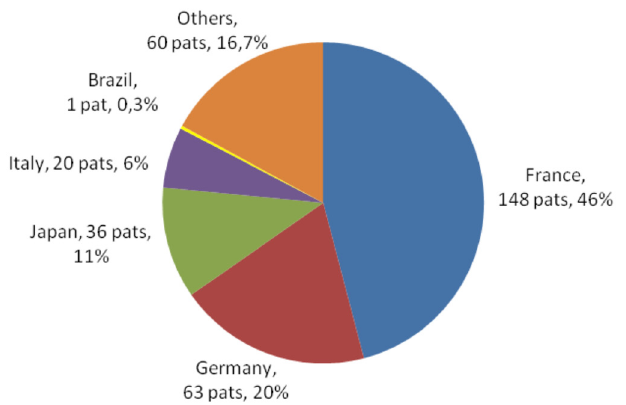
FIGURE 4 - Distribution of patents in the world according to EPO